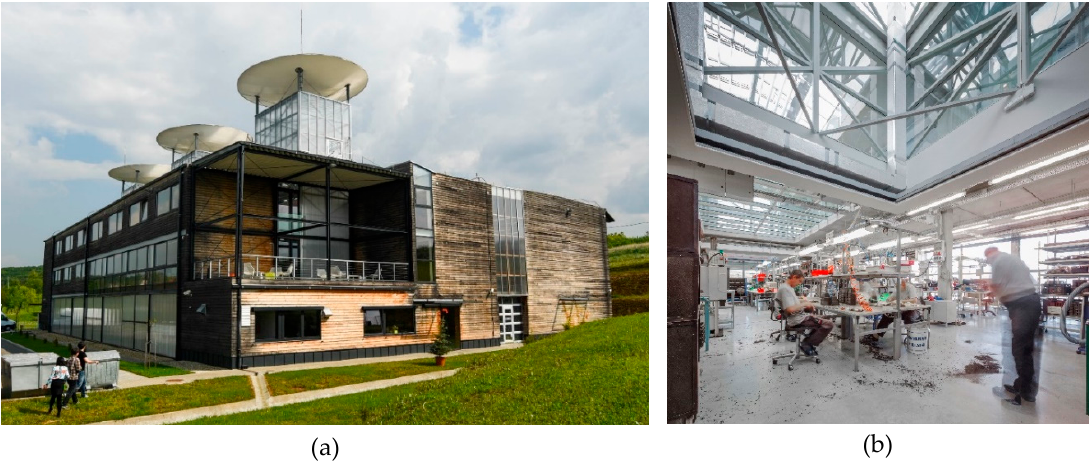
Figure 1. ( a ) Experimental reference industry and office building (RATI Ltd.) with passive ventilation towers and wind accelerator ‘Venturi’ deflectors; ( b ) production hall with adjacent ventilation chimney opening.